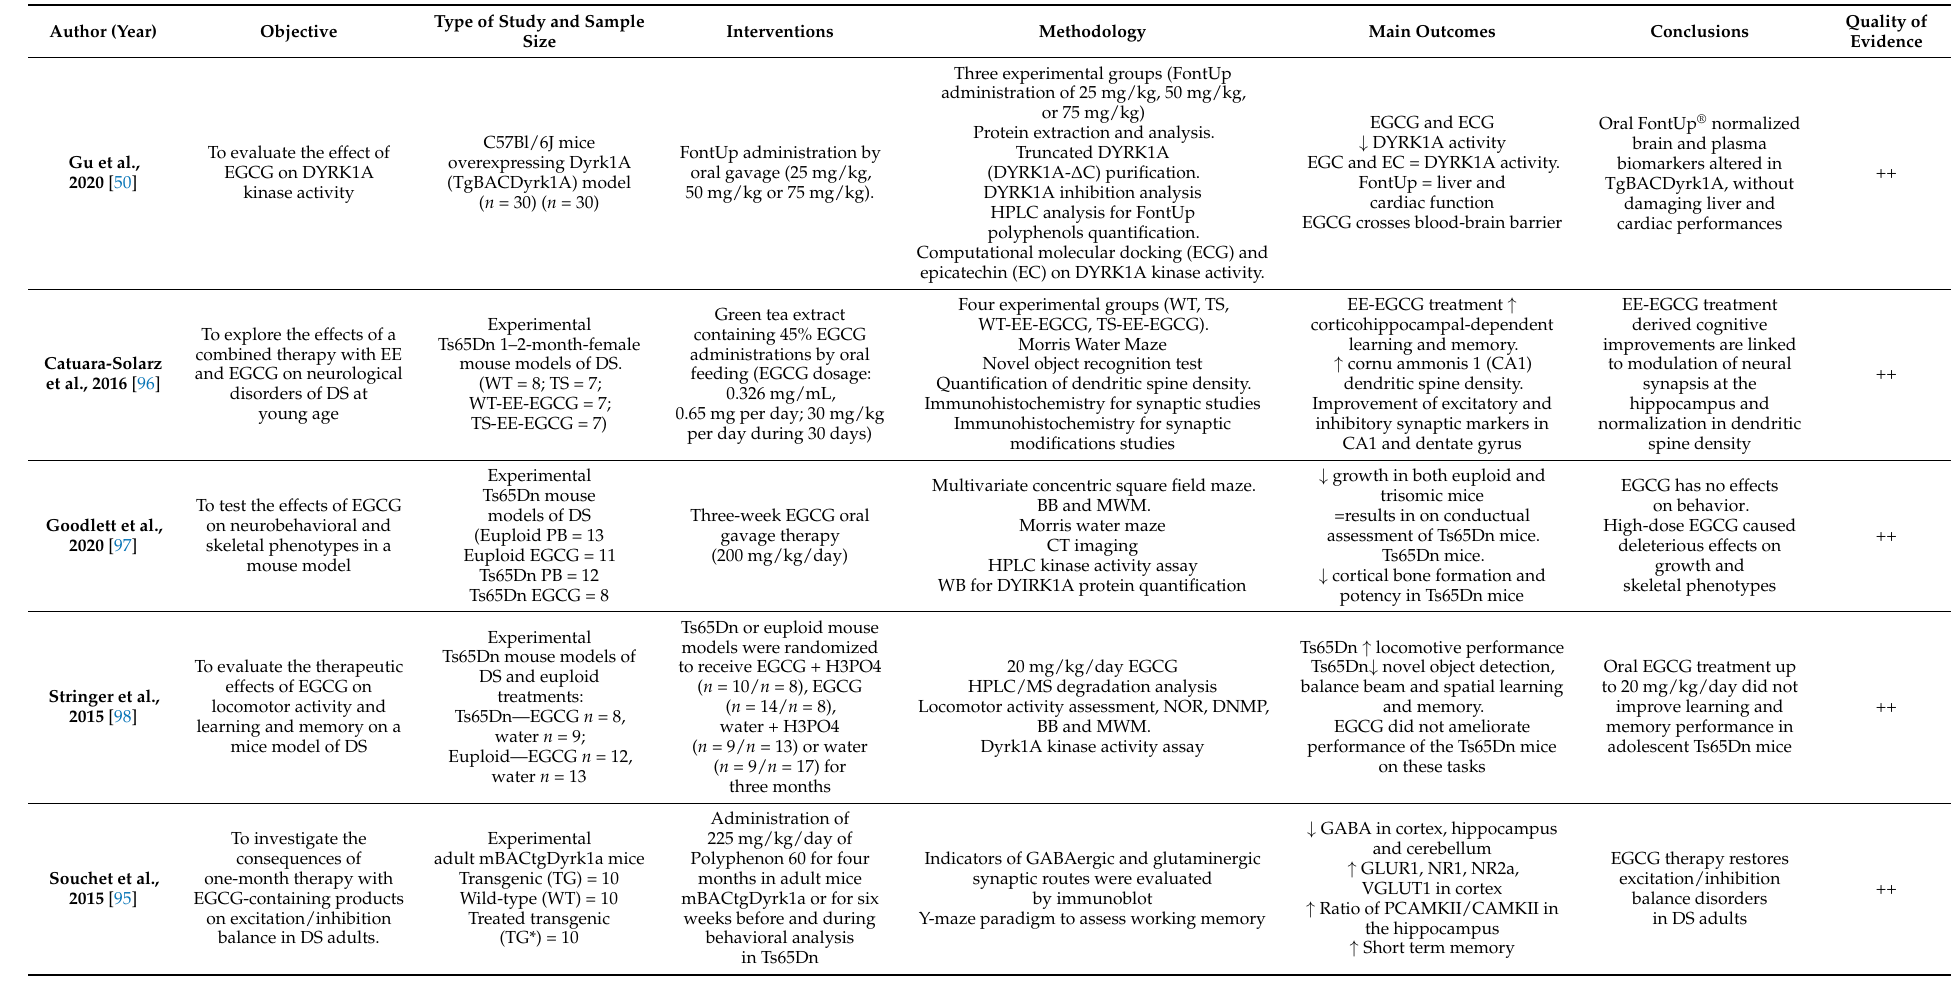
Table 3. Neurologic effects of catechins on Down